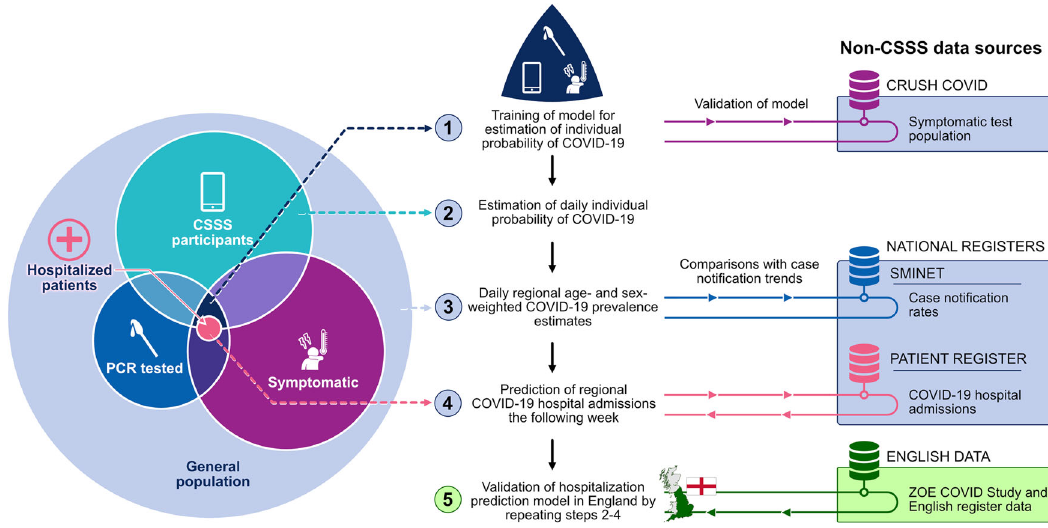
Fig. 2 Analysis strategy. Analysis strategy and data